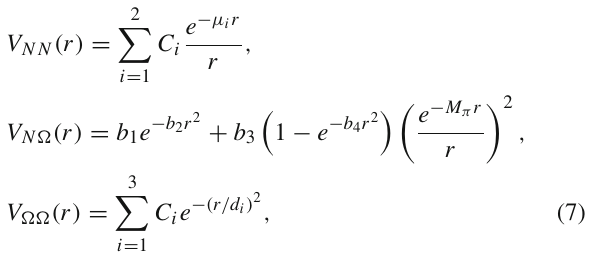
(cid:20) + r 2 r 2 1 2